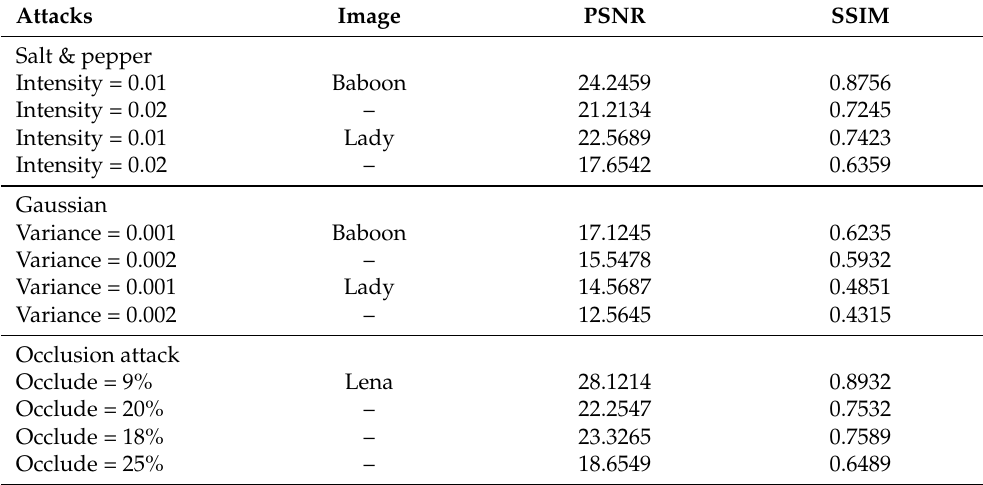
Table 10. Quality measure of affected decrypted